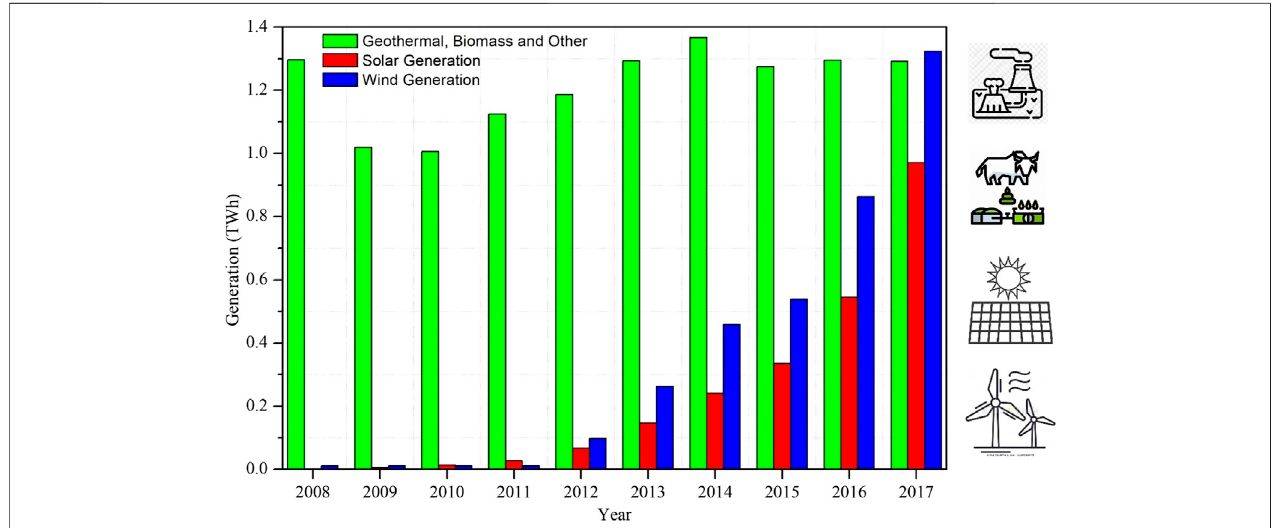
FIGURE 18 | RE generation in Pakistan in the past decade [Source Data: BP Statistics 2018 (BP, 2018)].